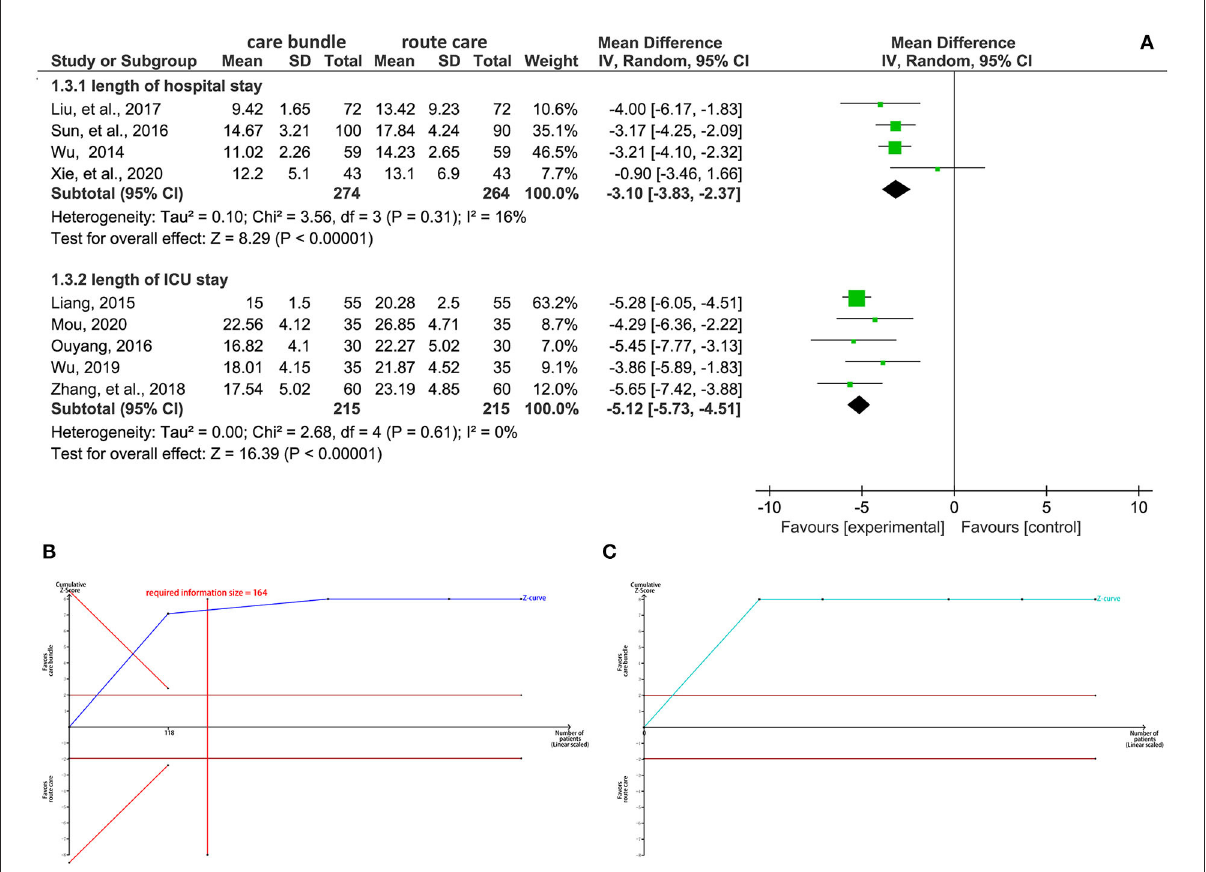
FIGURE5 Synthesis analysis of the length of hospital stay. (A) forest plot (B) results of TSA for hospital stay (C) results of TSA for ICU stay. CI, confidence interval; TSA, trial sequential analysis.